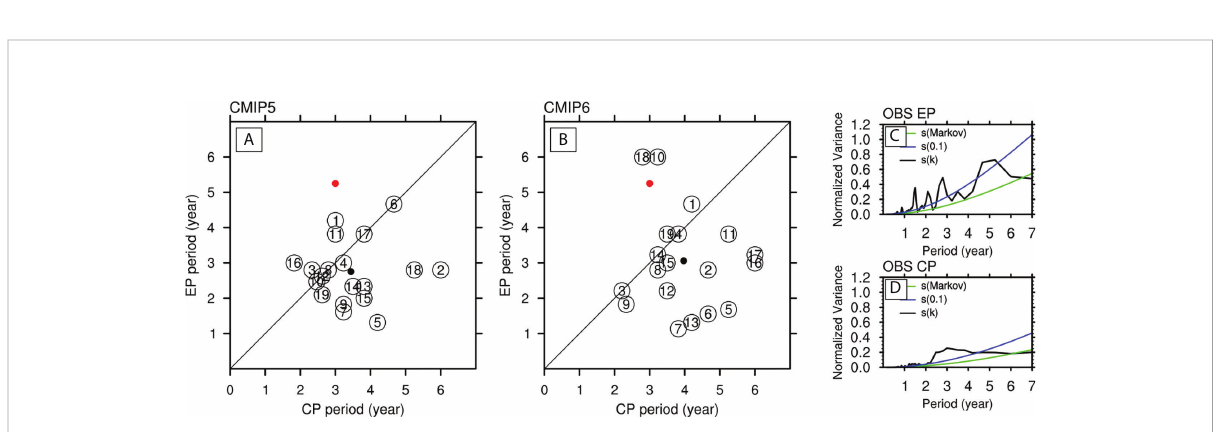
FIGURE 3 Scatter plots the leading periodicity for EP versus CP ENSO from (A) CMIP5 models and observations, and (B) CMIP6 and observations. The red dot represents the observational data, and the black denotes the model average. The normalized power spectrum for the observed (C) EP and (D) CP ENSOs from the HadISST (black lines). The green and blue lines denote the theoretical Markov “ red noise ” spectrum and the upper 90% con fi dence bound.